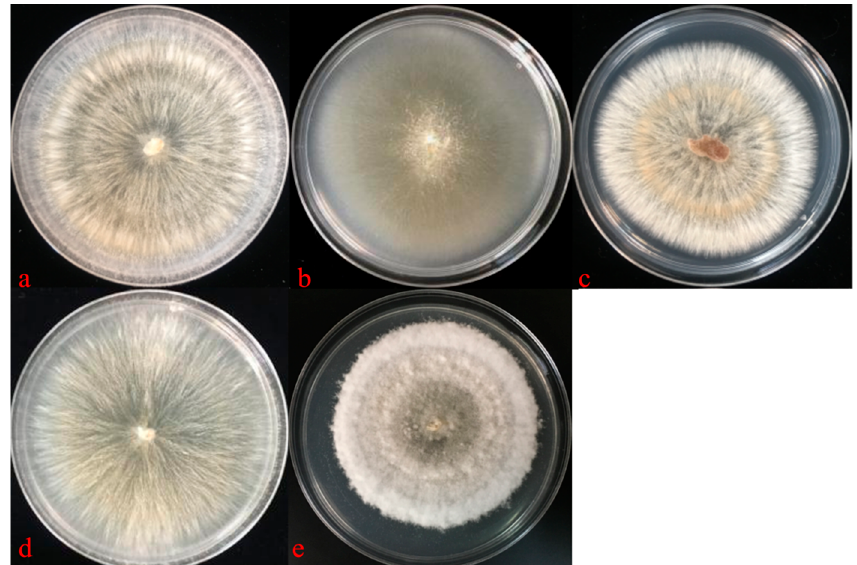
Figure 5. Colony morphology of some of the fungi isolated from the wild orchids. The fungi, which had been recovered from the roots of the four sampled epiphytic orchids, were cultivated on potato dextrose agar (PDA). ( a ) Ceratobasidium sp. Cer1 from Doritis pulcherrima , ( b ) Ceratobasidium sp. Cer2 from Renanthera coccinea , ( c ) Ceratobasidium sp. Cer3 from R. coccinea , ( d ) Ceratobasidium sp. Cer4 from D. pulcherrima , and ( e ) Ceratobasidium sp. Cer5 from Robiquetia succisa .